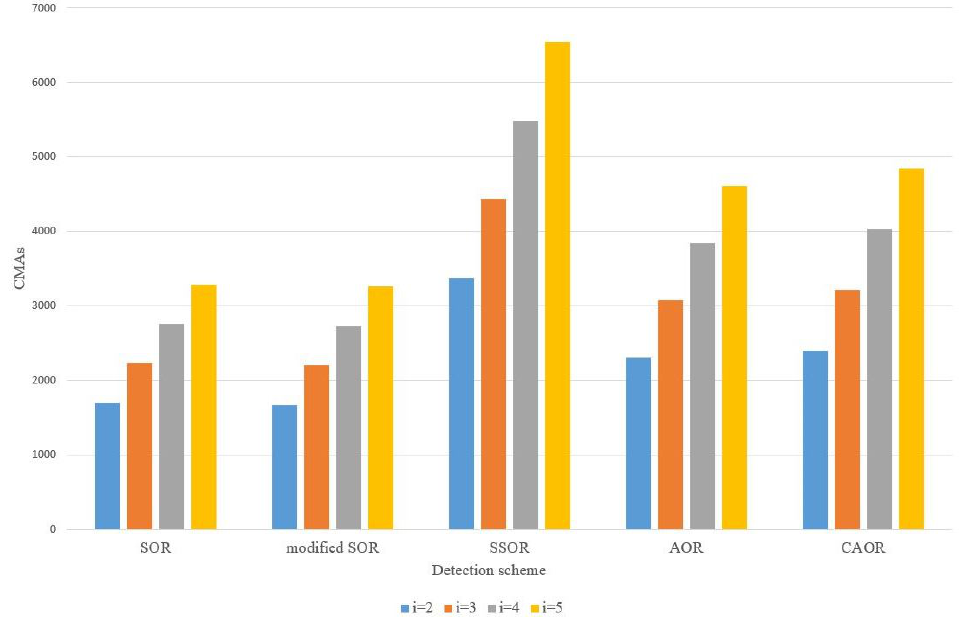
Figure 11. Computational complexity of different detection schemes with N T =